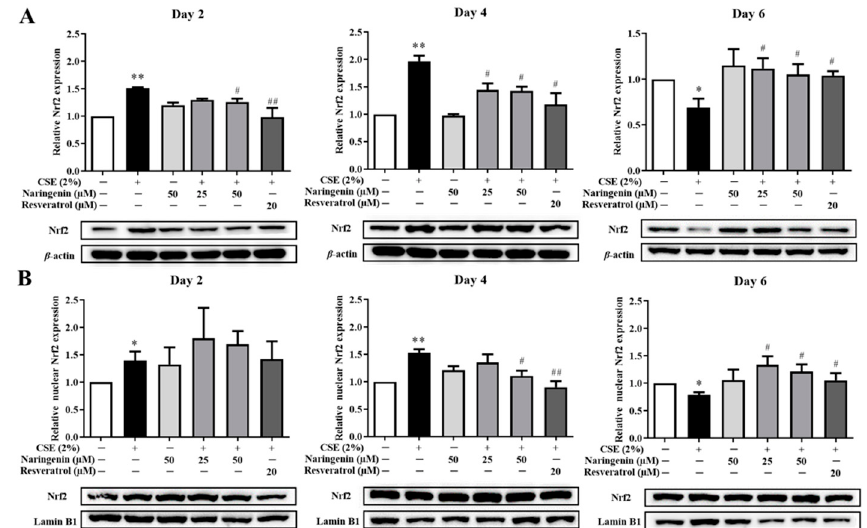
Figure 7. The effect of naringenin on CSE-induced total ( A ) and nuclear ( B ) protein expression of Nrf2 in BEAS-2B cells. The expression value was normalized by the housekeeping gene β -actin and lamin B1 respectively. Data are expressed as the means ± SD of at least three independent experiments for each data point. * p < 0.05, ** p < 0.01 vs. Control group; # p < 0.05, ## p < 0.01 vs. CSE alone group.